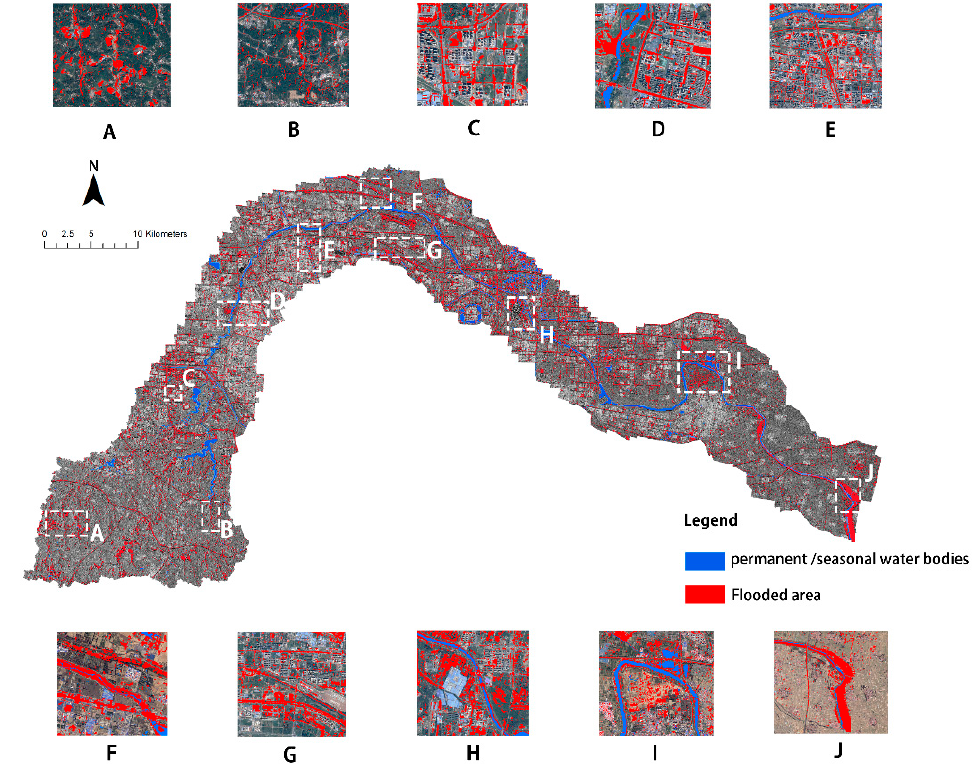
Figure 3. Maps of the extent of flood inundation at 10:31 pm on 20 July 2021 in the Jialu River System in greater Zhengzhou, China. The higher flood inundation intensity is shown for ten subsets ( A – J ) across the study